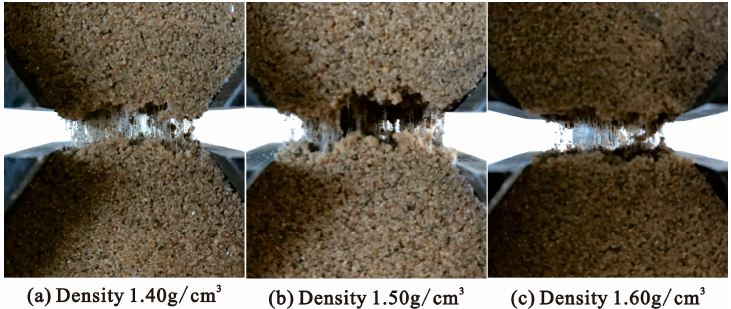
Figure 13. The failure module of 50% polymer-reinforced samples with different densities.